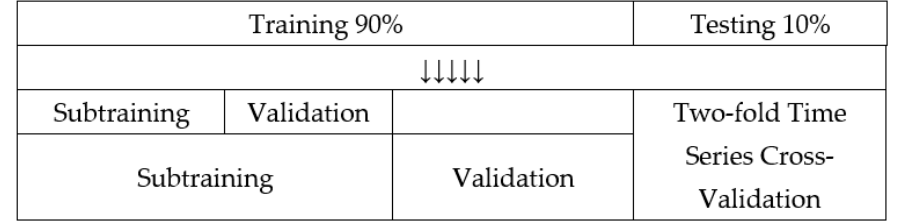
Figure 1. Two-fold time series